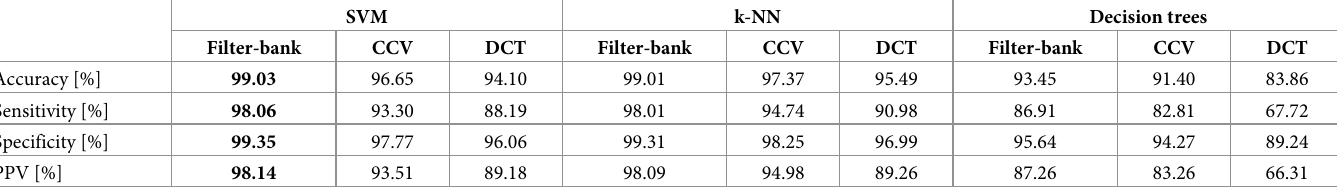
Table 2. Evaluation metrics of three learning models from classification tests. The highest performance values are achieved using filter-bank method. SVM